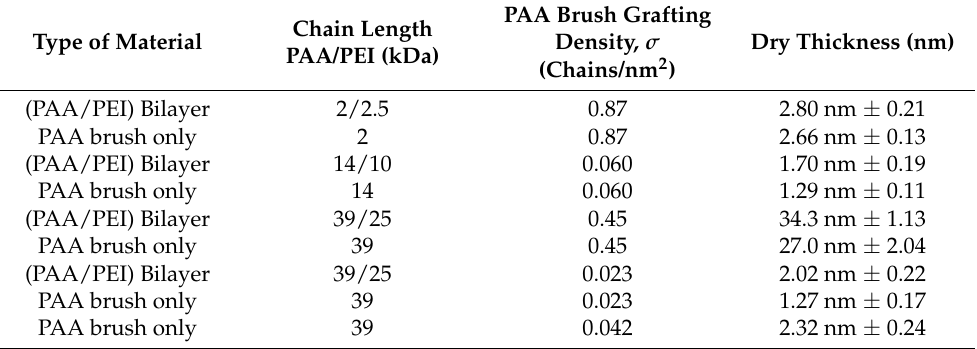
Table 1. Variable angle spectroscopic ellipsometry (VASE) results for the dry thicknesses of the poly(acrylic acid) (PAA) brushes and (PAA/PEI) bilayers investigated in this